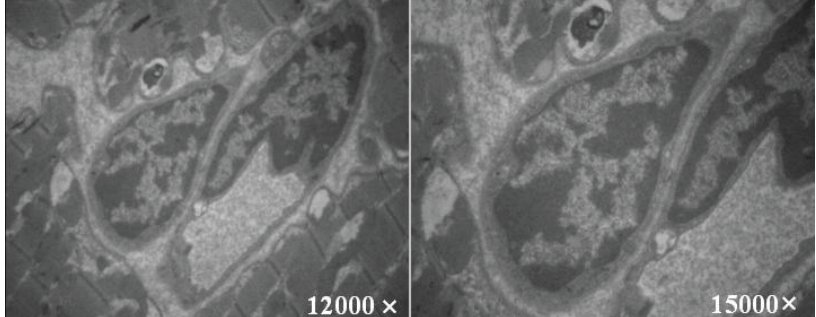
Figure 9. Electron micrographs of heart muscles of defibrillated dogs. Note that the digestive system [Golgi complex] is